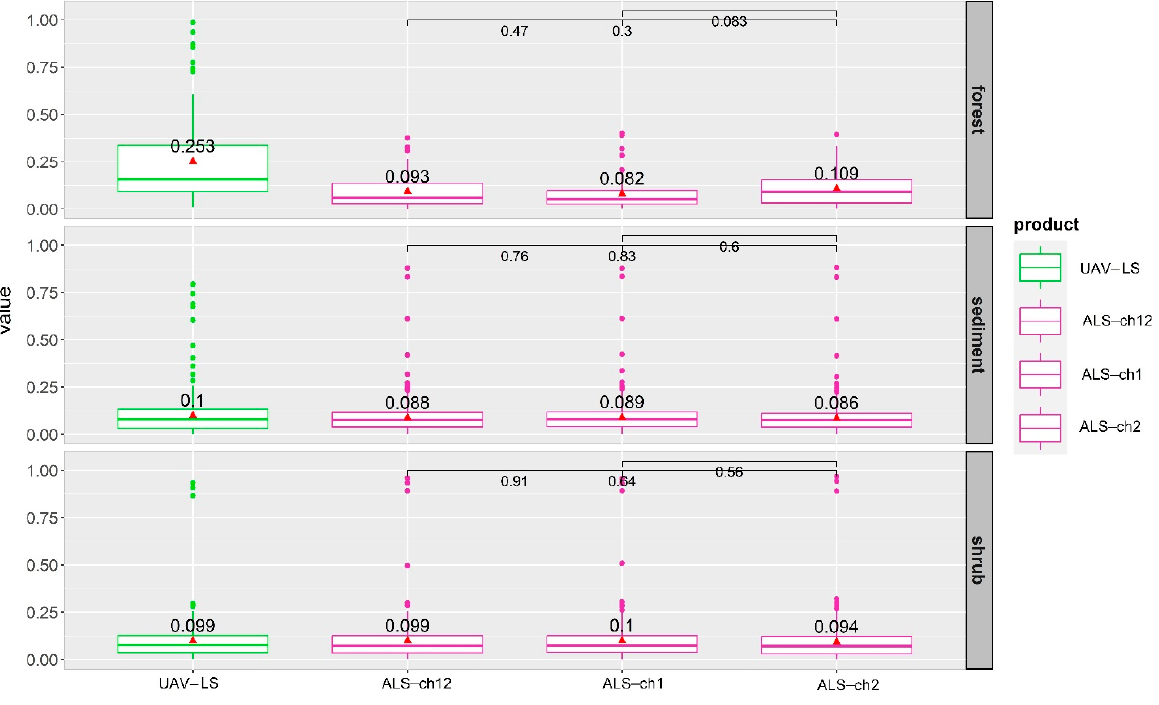
Figure 10. Accuracy of DTMs generated from LiDAR data obtained from UAV platform and from the aircraft (ALS) in two spectral channels separately and combined. The comparison is grouped by the di ff erent land cover classes analysed.